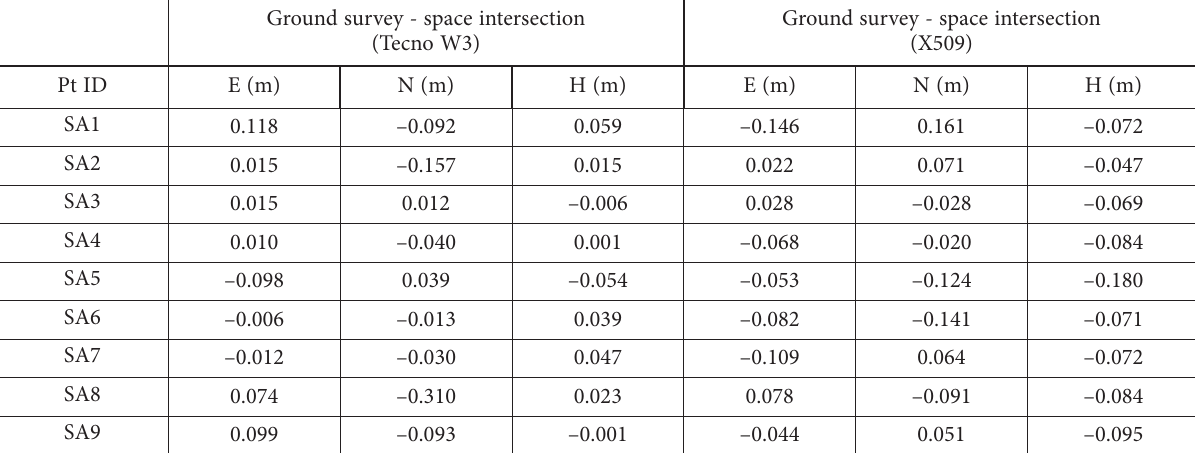
Table 4. Residuals of obtained coordinates from space intersection with those from ground survey method Ground survey - space intersection (Tecno W3)